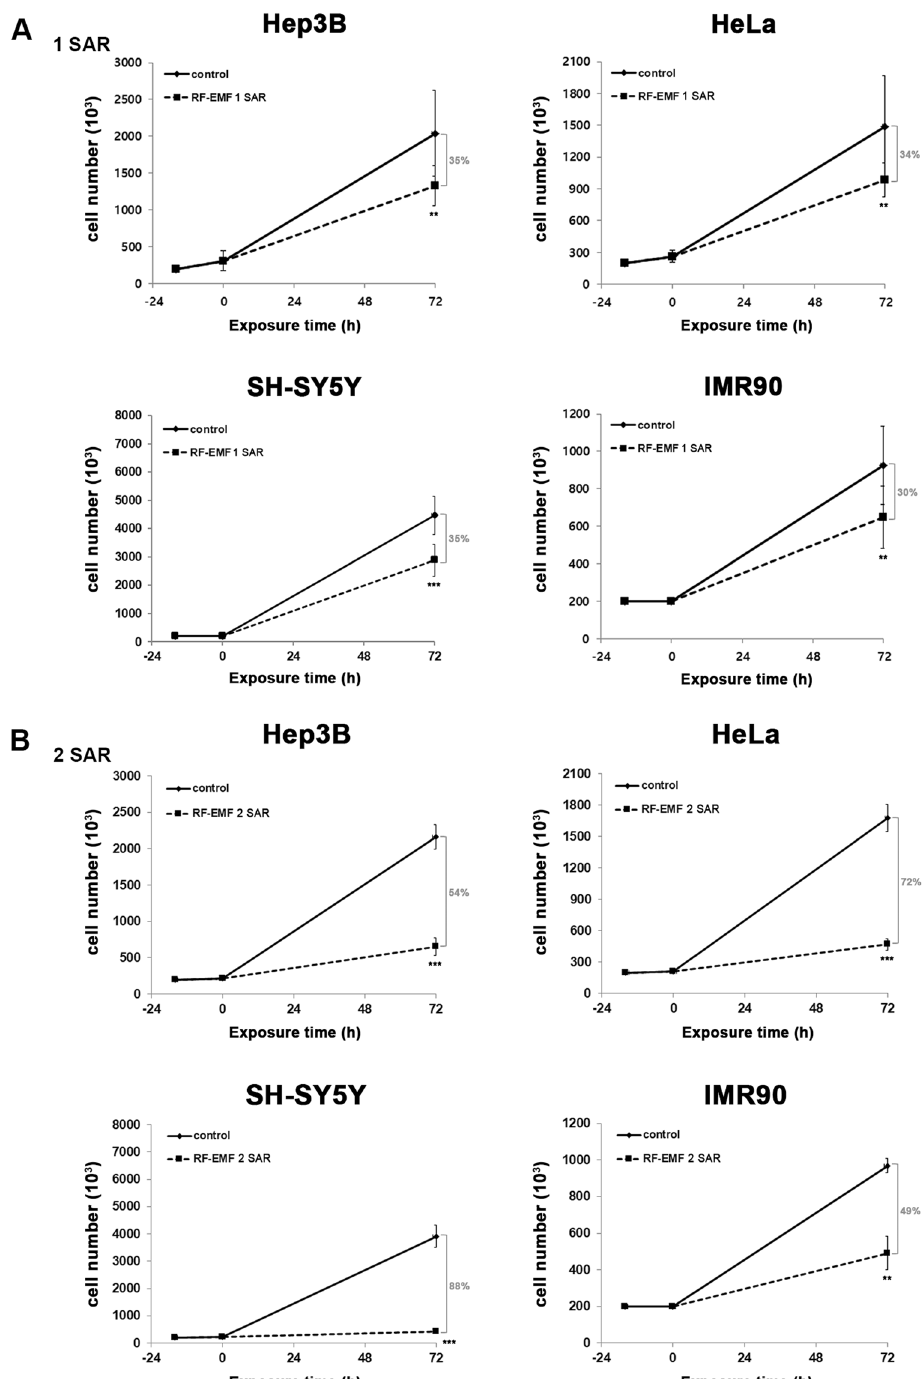
Figure 4. Continuous exposure to 1.7 GHz LTE RF-EMF decreased the proliferation of various human cells. ( A,B ) Hep3B, HeLa, SH-SY5Y, and IMR 90 cells were exposed to LTE 1.7 GHz RF-EMF for 72 h at 1 SAR ( A ) or 2 SAR ( B ). The sham control cells were incubated for 72 h without RF-EMF exposure. After the exposure, cells were collected and counted with a cell counter (Nexcelom Bioscience). At least three independent experiments were performed and the cell numbers were plotted as mean ± S.D. P < 0.01( ** ), P < 0.001( *** ), and P > 0.05 (non-significant,